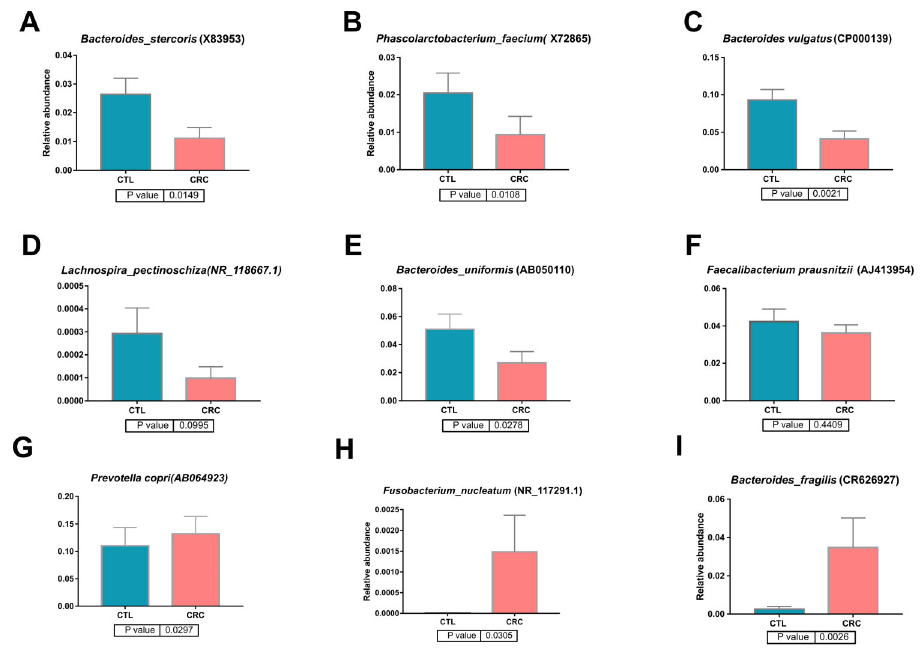
Figure 4. Comparison of the relative abundance of bacterial species in the intestinal microbiota of the control (CTL) and colorectal adenocarcinoma (CRC) groups.